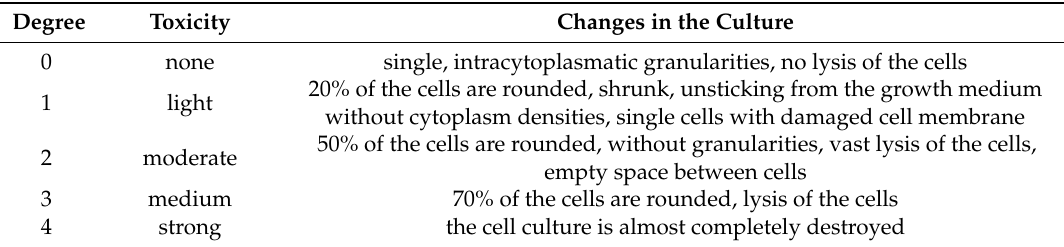
Table 3. Toxicity degrees in direct contact